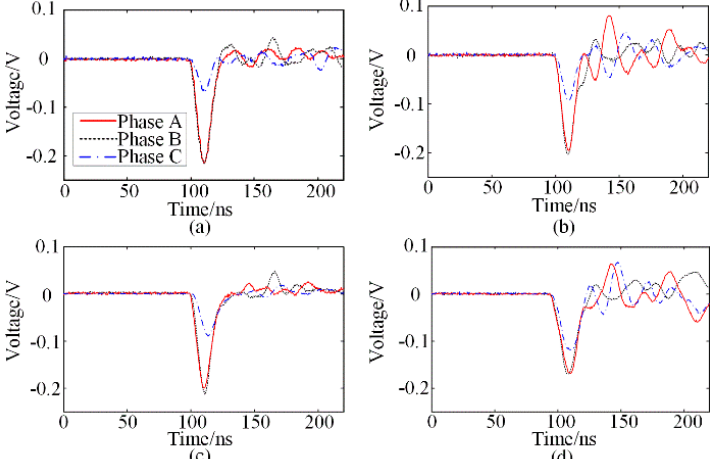
Figure 8. Signals under different laying configurations. ( a ) Triangle arrangement, on the ground. ( b ) Triangle arrangement, 0.5m above the ground. ( c ) Horizontal arrangement, on the ground. ( d ) Horizontal arrangement, 0.5m above the ground.